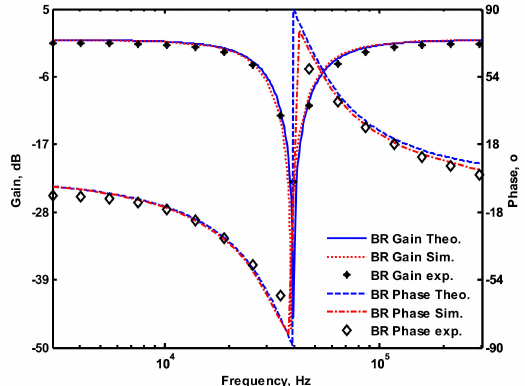
Figure 9. Simulation and experimental results of BR filtering responses at V o3 when V i1 = V in and V i2 =